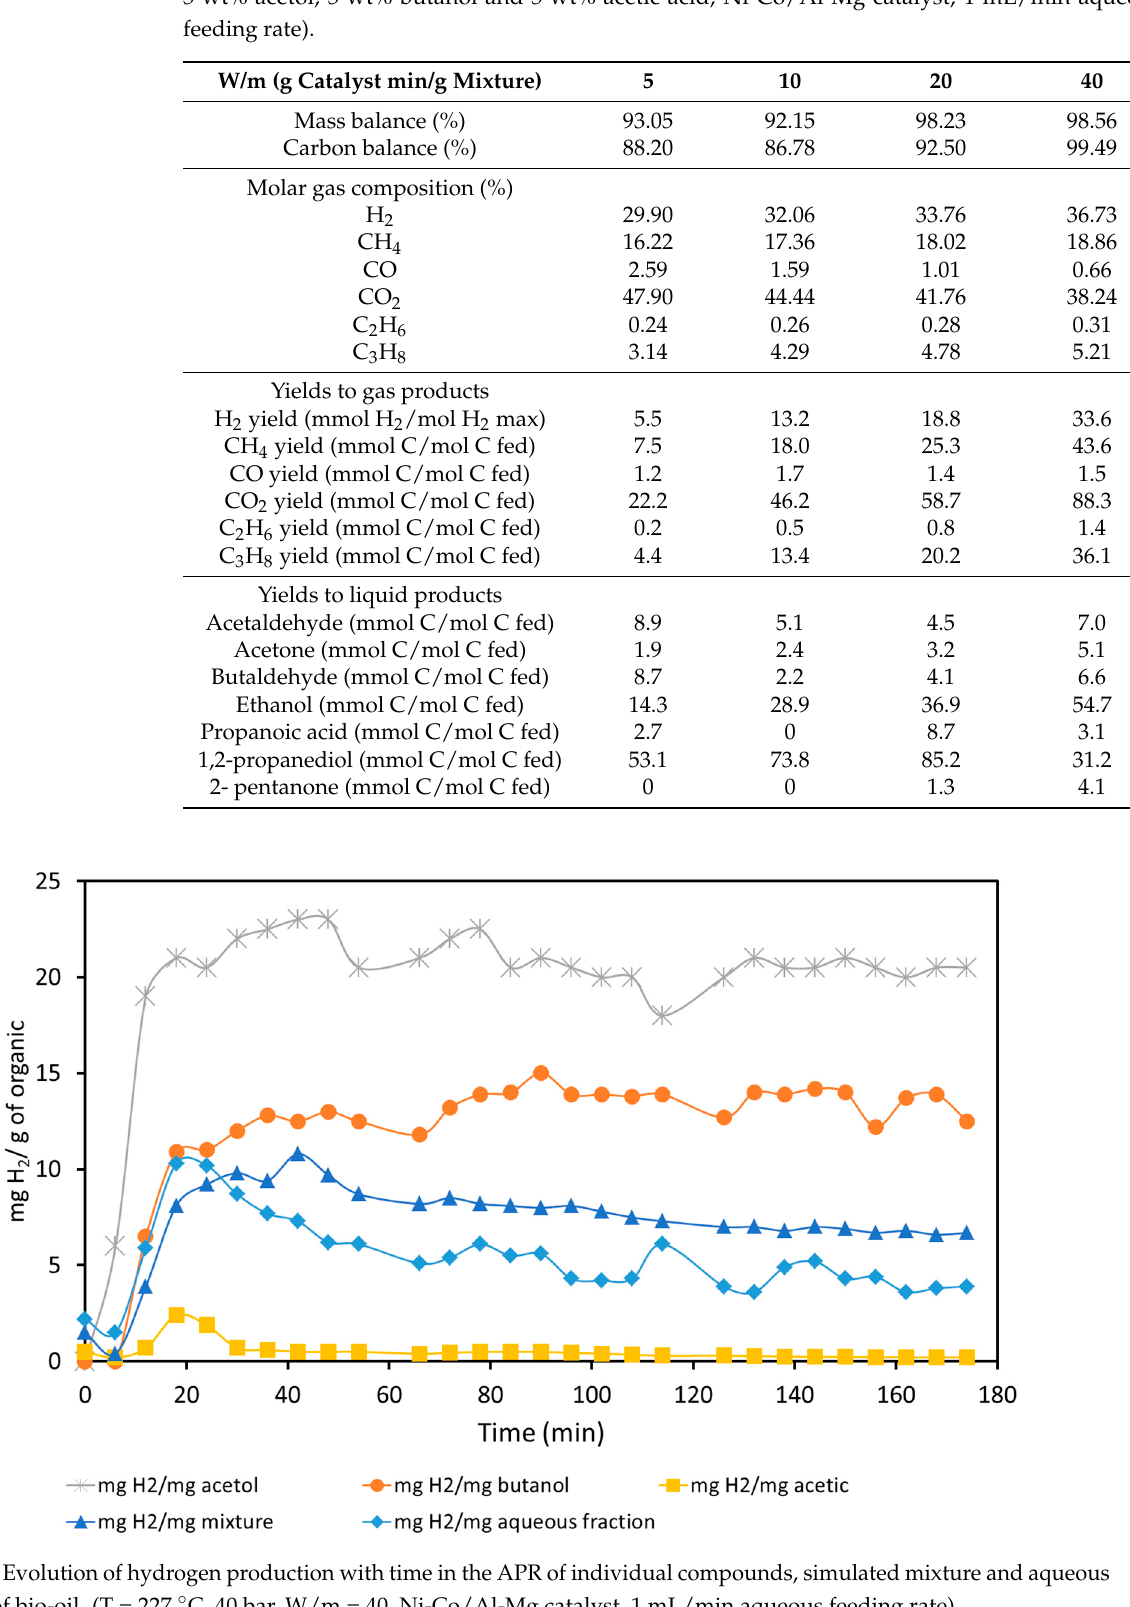
Table 5. Results of APR experiments of a simulated aqueous fraction of bio-oil (T = 227 ◦ C, 40 bar, 5 wt% acetol, 5 wt% butanol and 5 wt% acetic acid, Ni-Co/Al-Mg catalyst, 1 mL/min aqueous